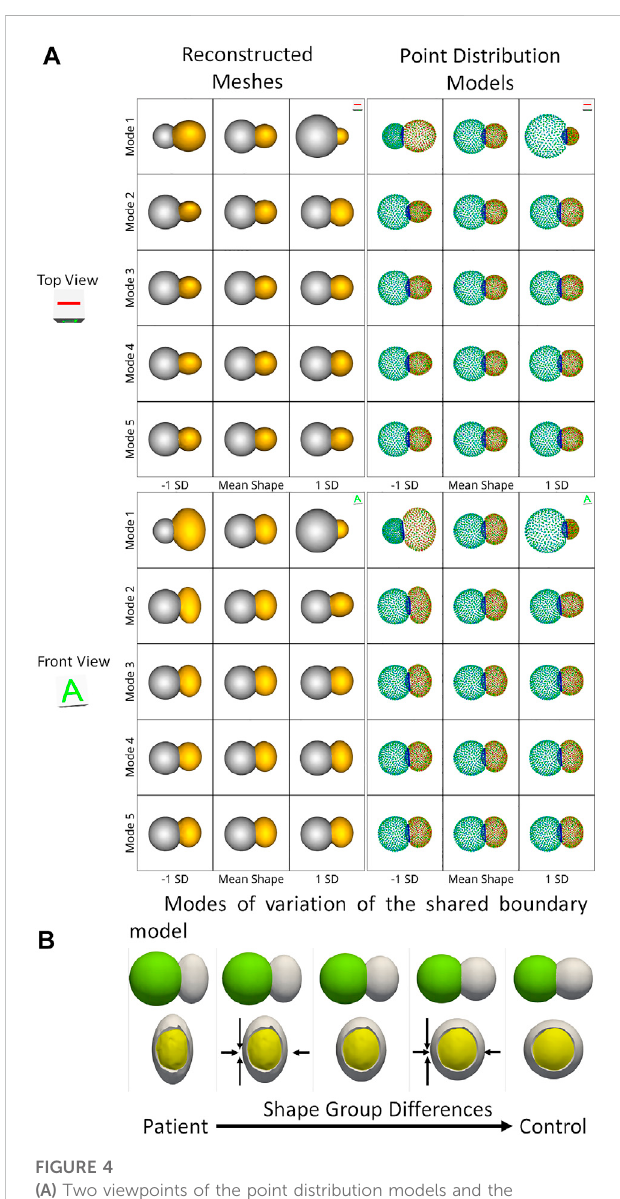
FIGURE 4 (A) Two viewpoints of the point distribution models and the reconstructed meshes of the modes of variations of the peanut dataset discovered by the shared boundary model. (B) Group-level shape differences observed by the shared boundary shape model. The arrows indicate the direction of shape change, the yellow mesh represents the extracted shared boundary,and the white represents one of the shapes of the